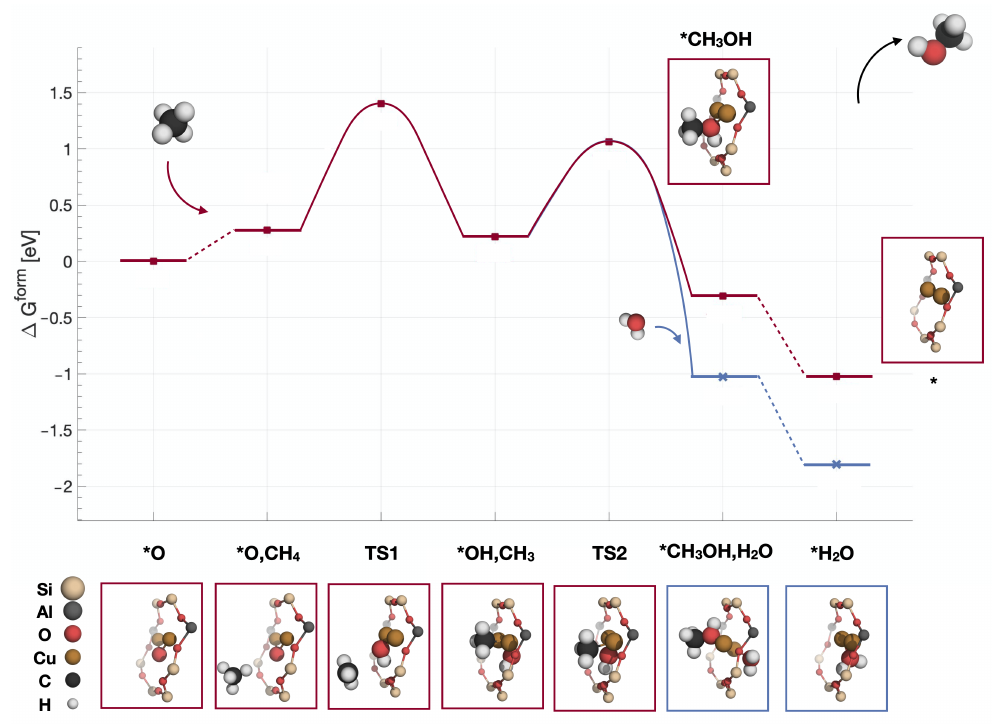
Figure 2. Reaction path over Z 2 [Cu 2 O]. Gibbs free energies are in eV and relative to that of Z 2 [Cu 2 O] with CH 4 in the gas phase. The red squared path shows the reaction for dry conditions. Adding water to the mechanism gives the blue cross path. Both paths are exergonic. Reaction conditions are set to T = 448 K, p CH = 2%, p H = 10% and p CH = 10 − 9 %, with respect to atmospheric pressure. 2 O 3 OH 4 TS, transition